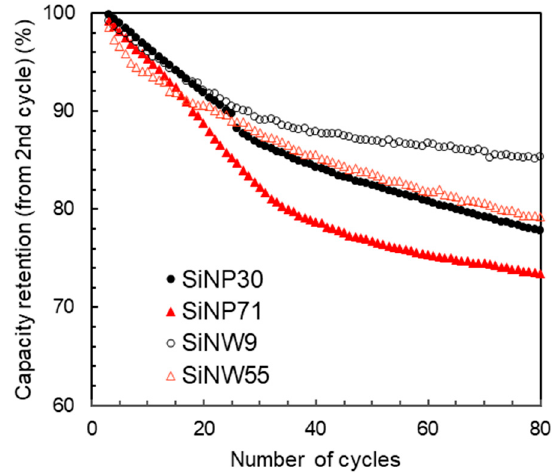
Figure 9. Capacity retention for small (black circles) and large (red triangles) SiNPs (full symbols) and SiNWs (empty symbols).